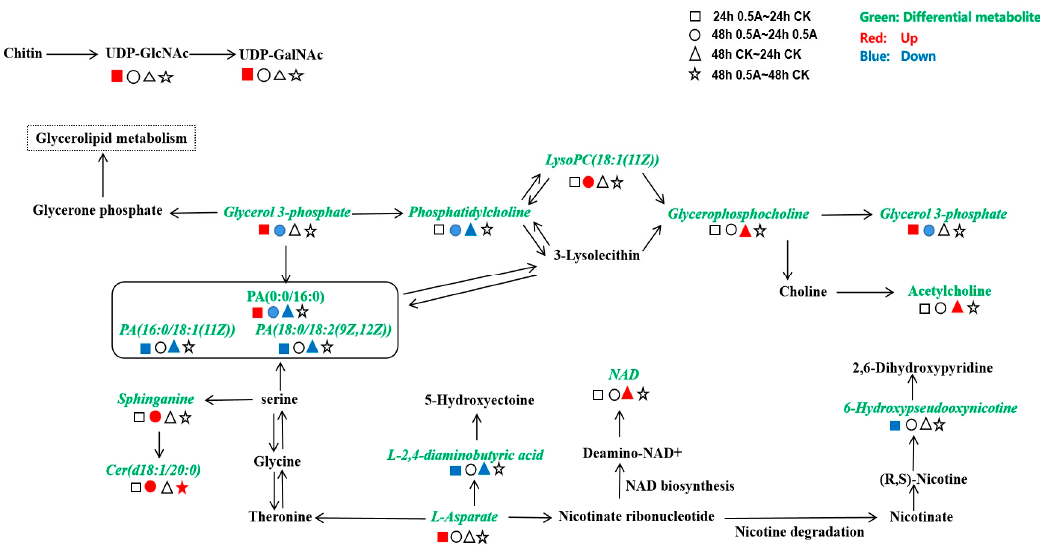
Figure 8. Diagram of the main KEGG metabolic network pathways of the differential metabolite under 0.5 mg/L ABM stress. Different shapes were used to represent different groups, and different colours represent metabolite information. For example, a square filled with red represents the up-regulated differential metabolites in the 24 h 0.5 A - 24 h CK group.